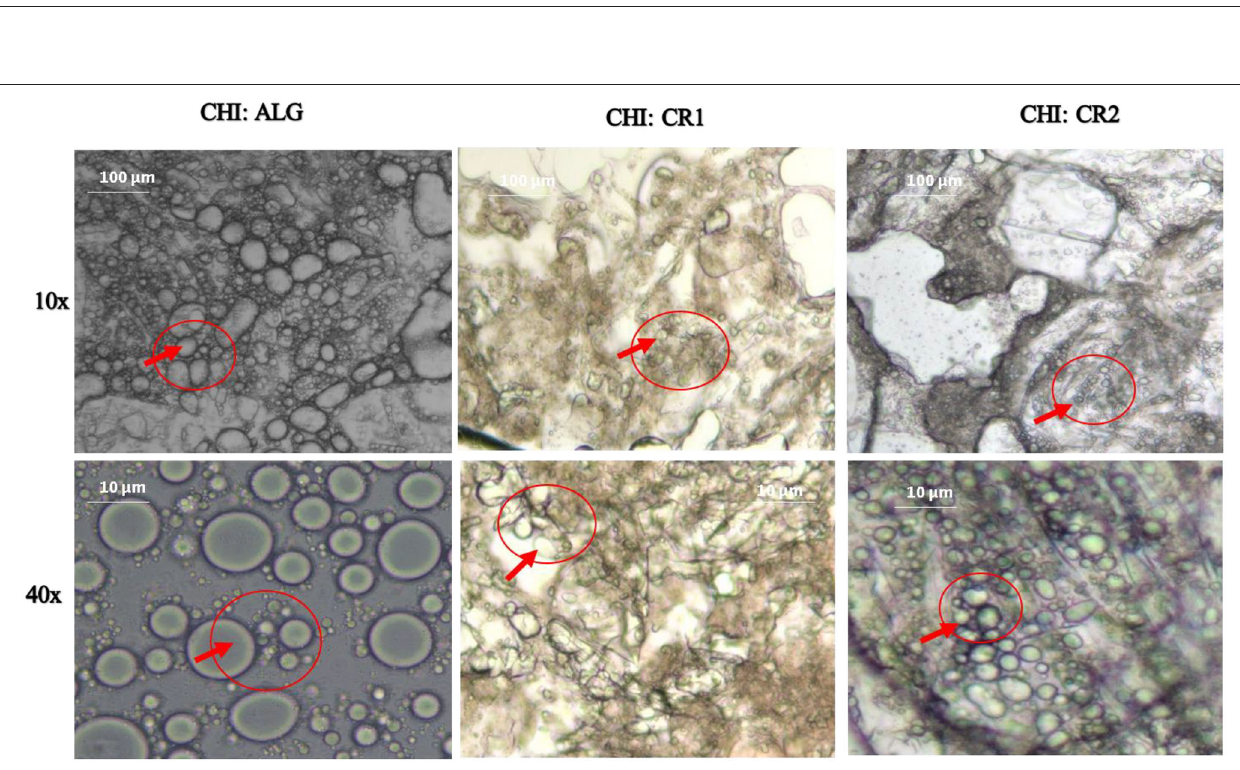
25:75) with 20% w/w of canola oil. =